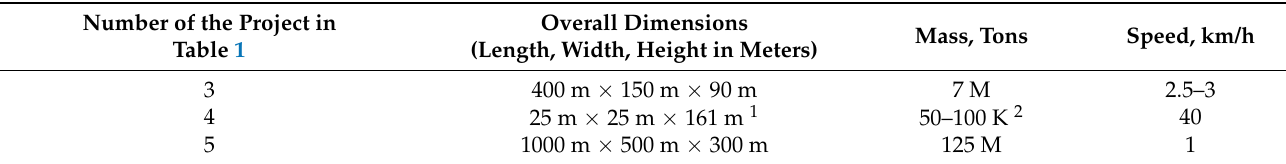
Table 2. Iceberg’s parameters assumed in major projects in accordance with Table 1 (own elaboration). Number of the Project in Table